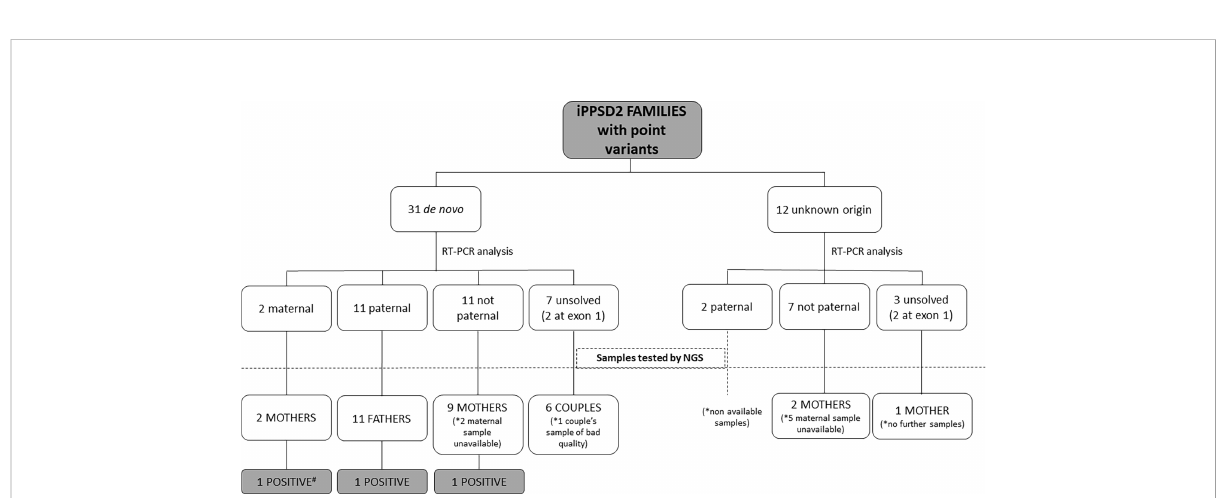
FIGURE 1 Schematic representation of the type of samples analyzed from the iPPSD2 families with variant of de novo or unknown origin and the obtained results. *: Number of unavailable samples for NGS studies. #: Sample used as positive